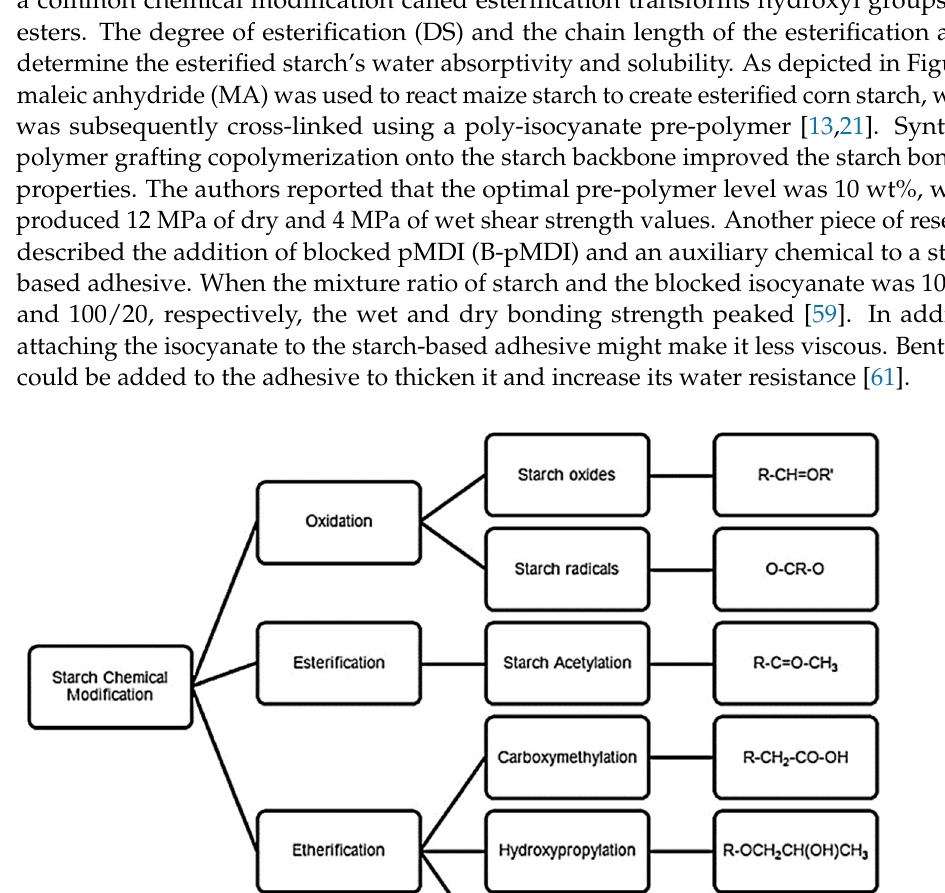
friendly starch-based wood adhesive for producing wood-based composites [44,107]. The authors concluded that developing a complex network structure and greater crosslinking density was responsible for the starch-based adhesive’s improved